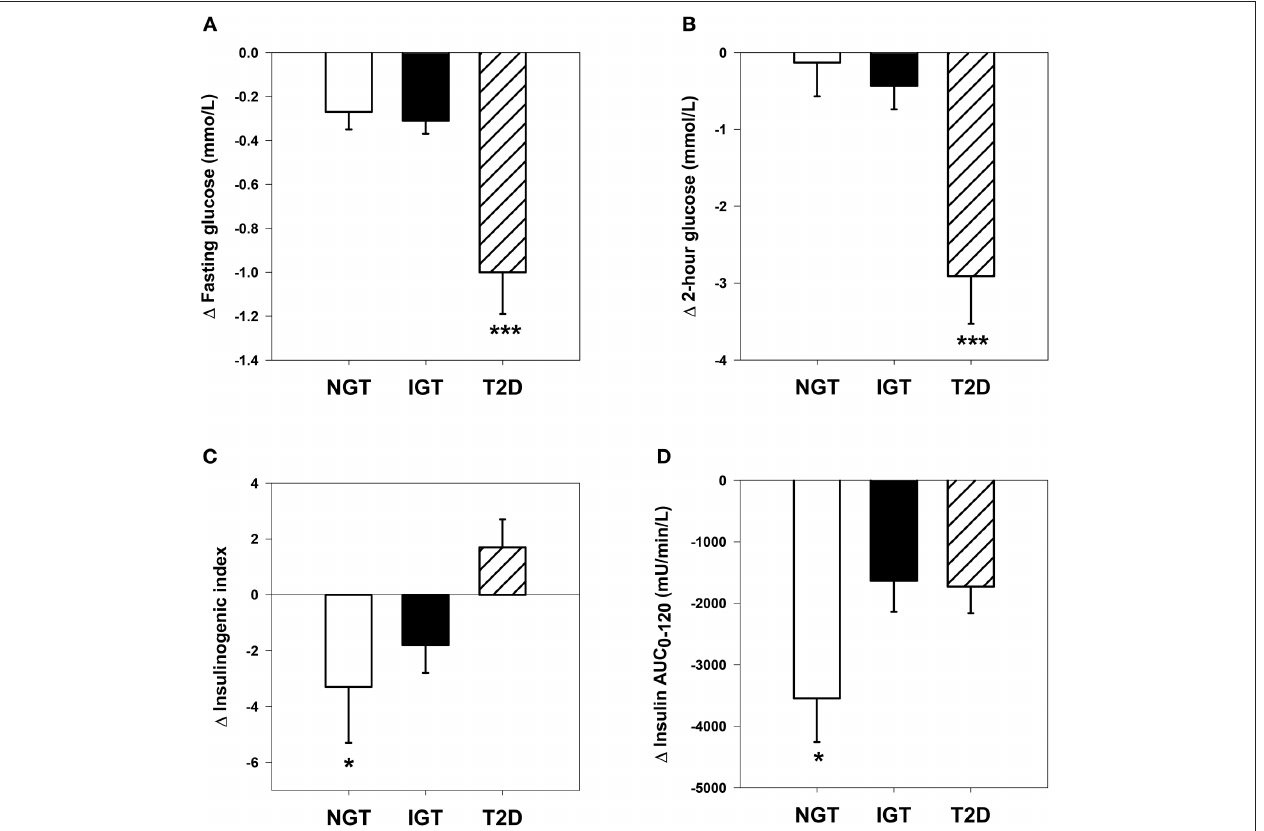
FIGURE 1 | Comparative changes in glucose and insulin parameters. (A) Fasting plasma glucose: time effect, P < 0.001; time × group interaction, P < 0.001. *** P < 0.001 vs. NGT and IGT groups. (B) Two-hour plasma glucose following oral glucose tolerance test: time effect, P < 0.001; time × group interaction, P < 0.001. *** P < 0.001 vs. NGT and IGT groups. (C) Insulinogenic index: time × group interaction, P = 0.04. * P < 0.05 vs. T2D group. (D) Plasma insulin area under the curve during oral glucose tolerance test: time effect, P < 0.001; time × group interaction, P = 0.04. * P < 0.05 vs. IGT and T2D